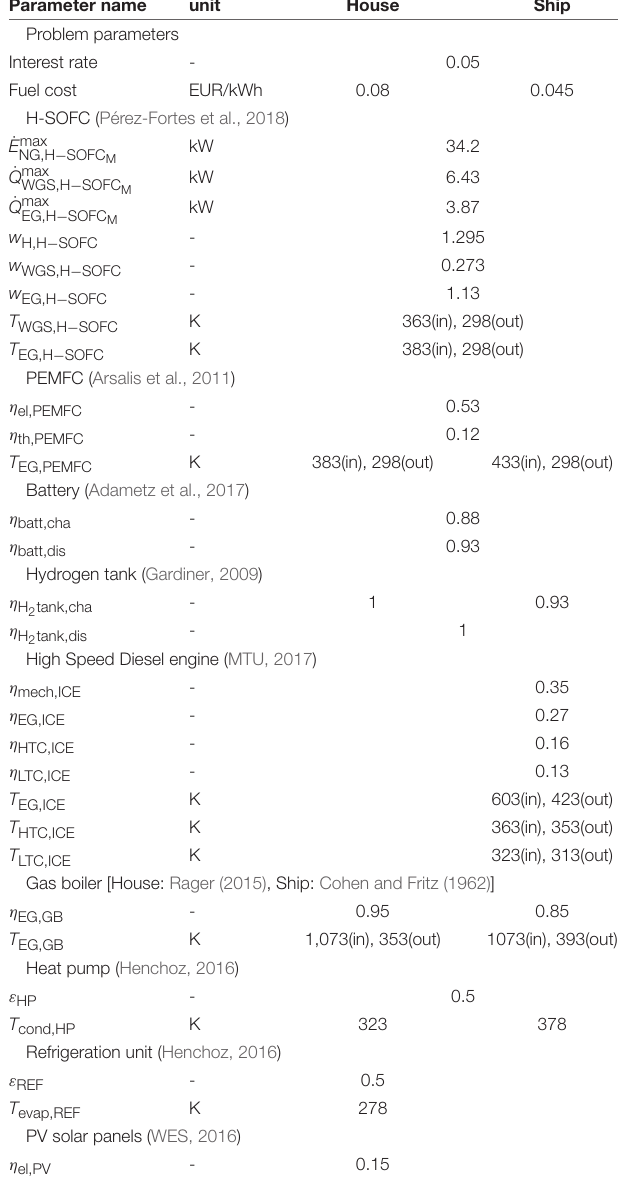
TABLE 1 | Stream definition for each unit in the